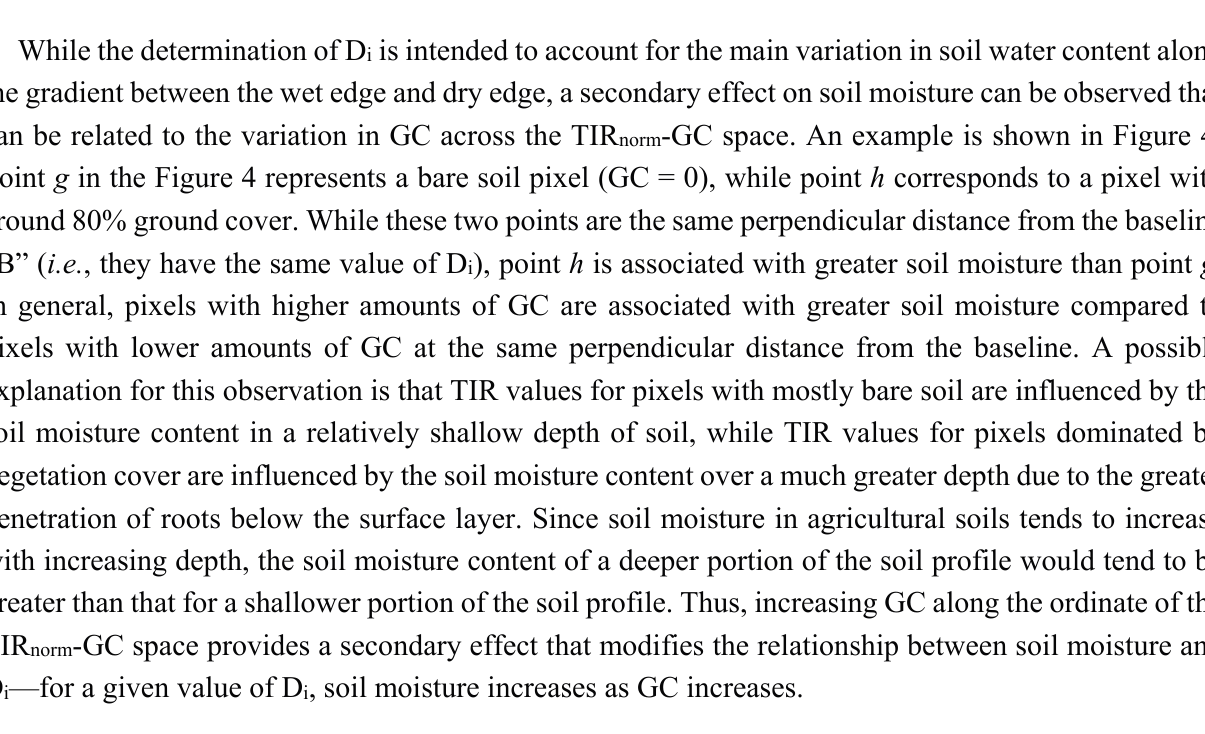
Figure 3. Diagrammatic representation of the perpendicular distance from a point ( f ) in the TIR norm -GC space to the baseline “B” passing though the origin (point e